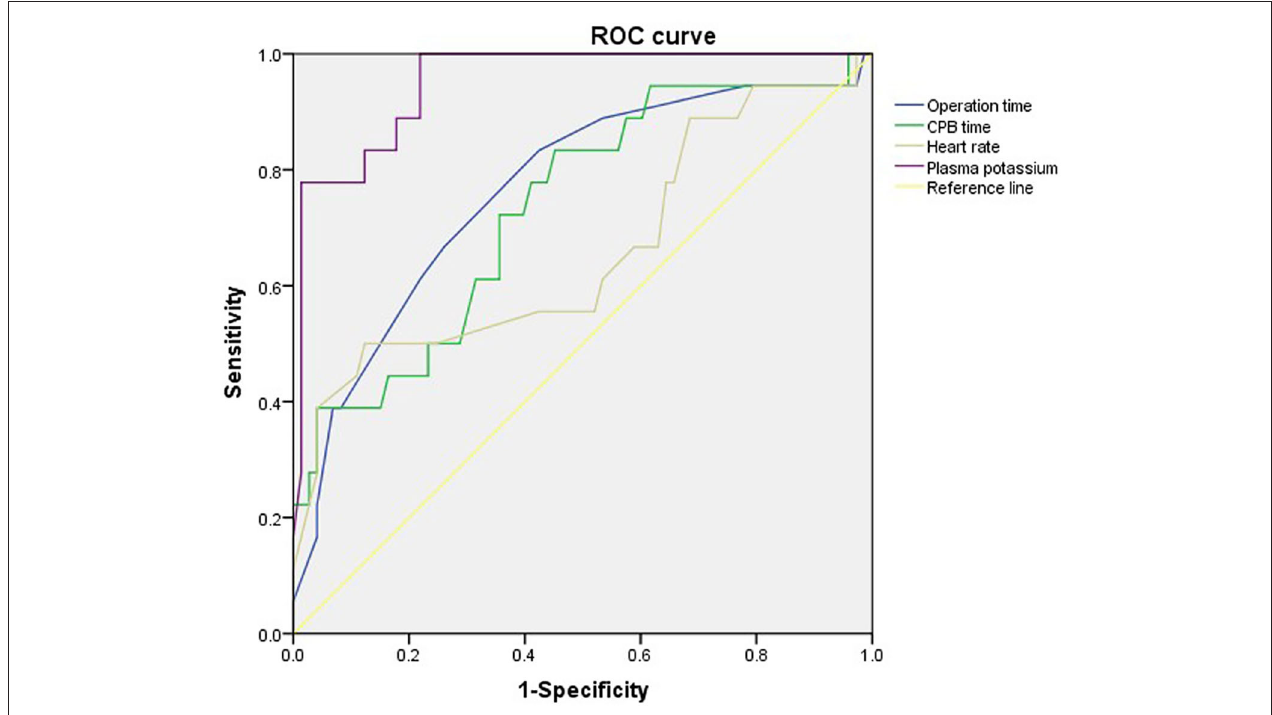
FIGURE 1 | Receiver-operating characteristic curves of operation time, extracorporeal circulation time, admission heart rate and blood potassium level to identify mortality in ATAAD patients.